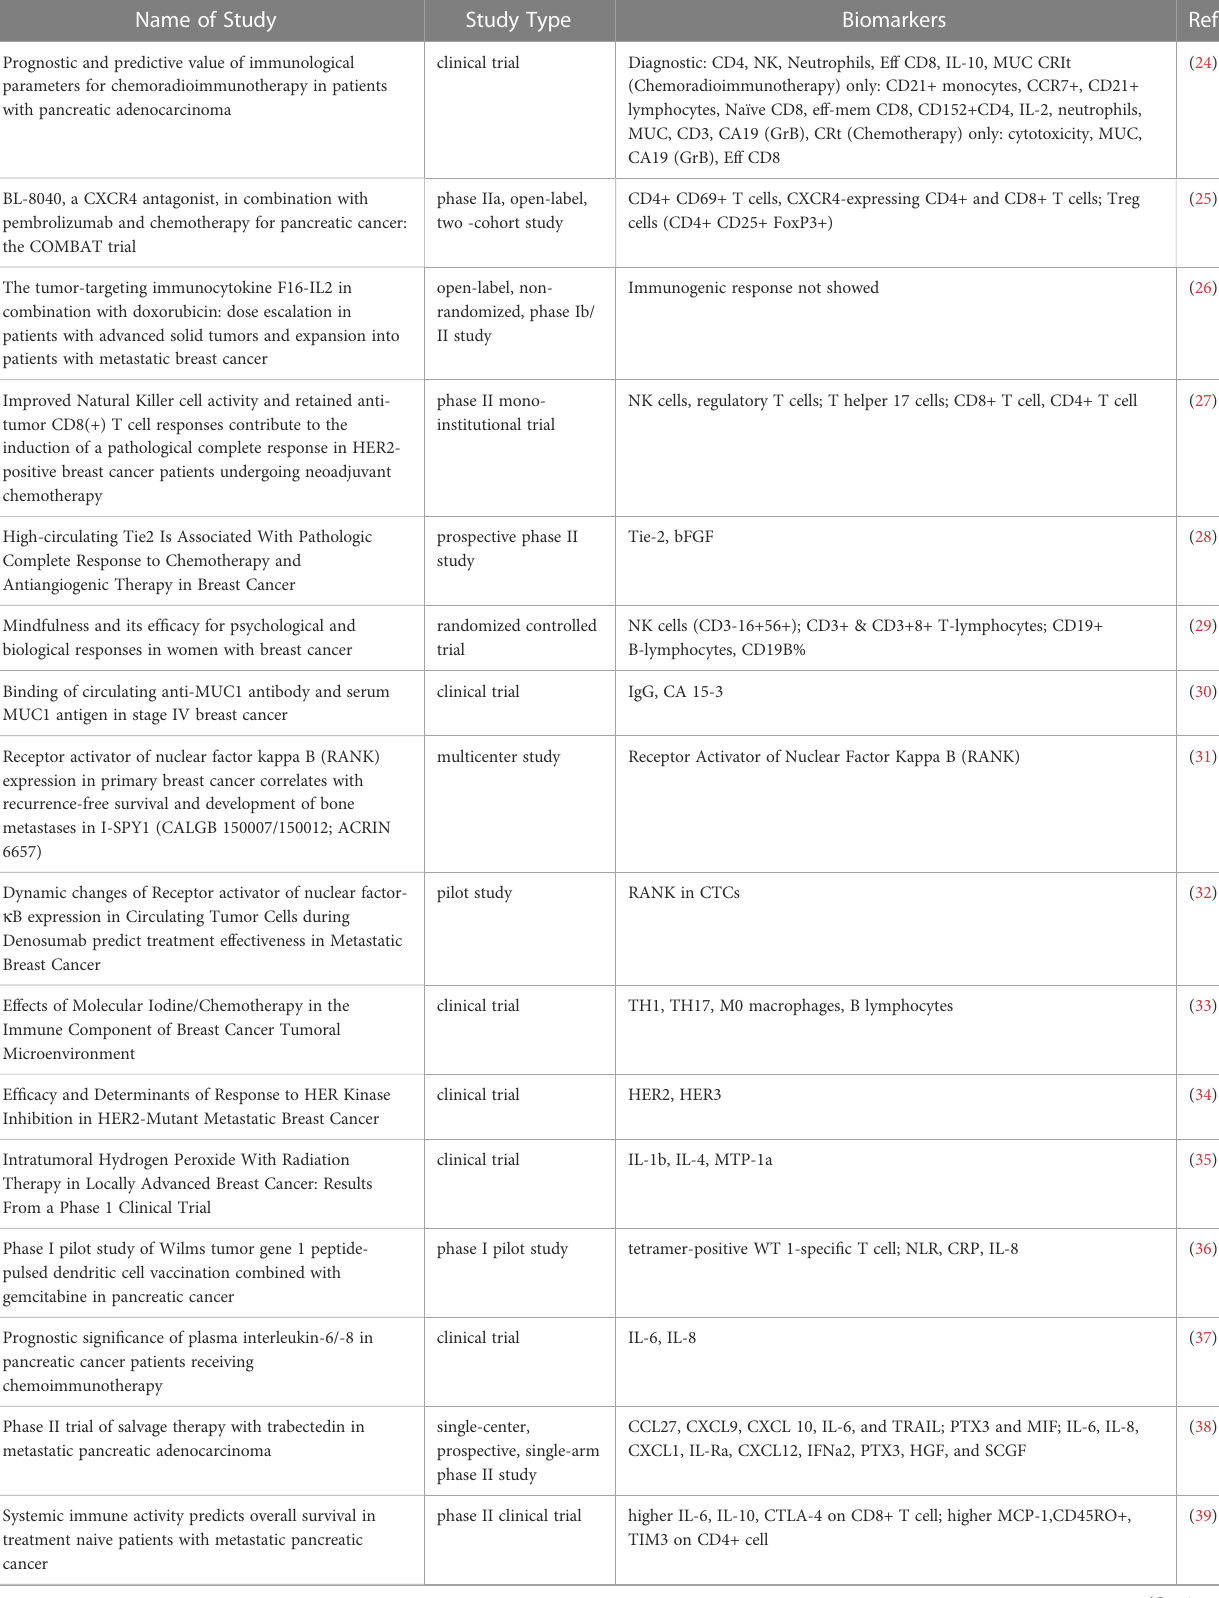
TABLE 2 Summary of all studies included in review with details for detected